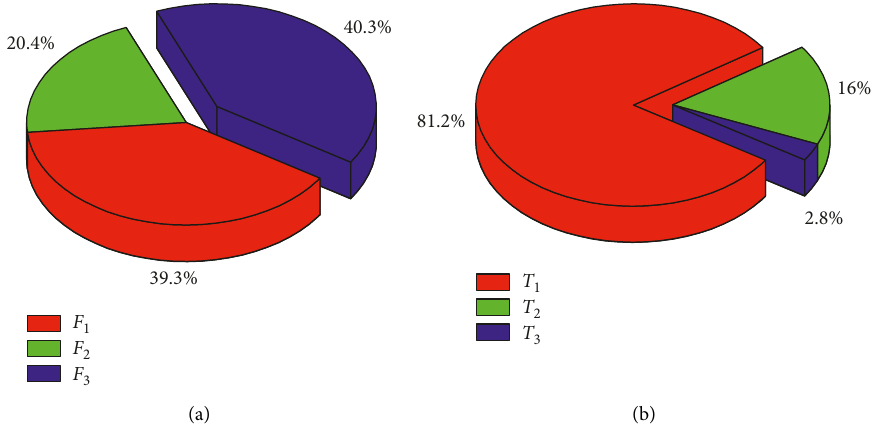
Figure 6: Percentage of various forces in the shield cutter head